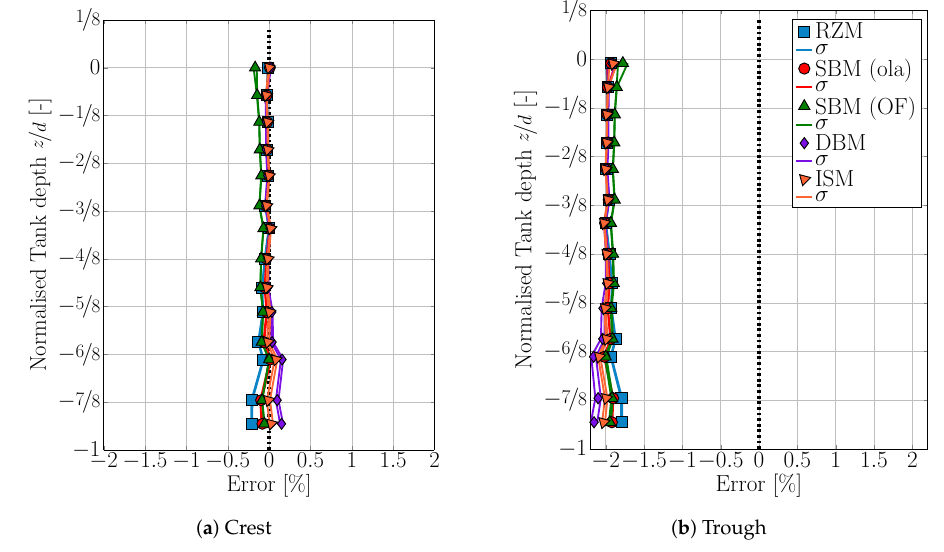
Figure 16. Velocity profiles of the horizontal velocity component along the water depth for wave crests ( a ) and trough ( b ).